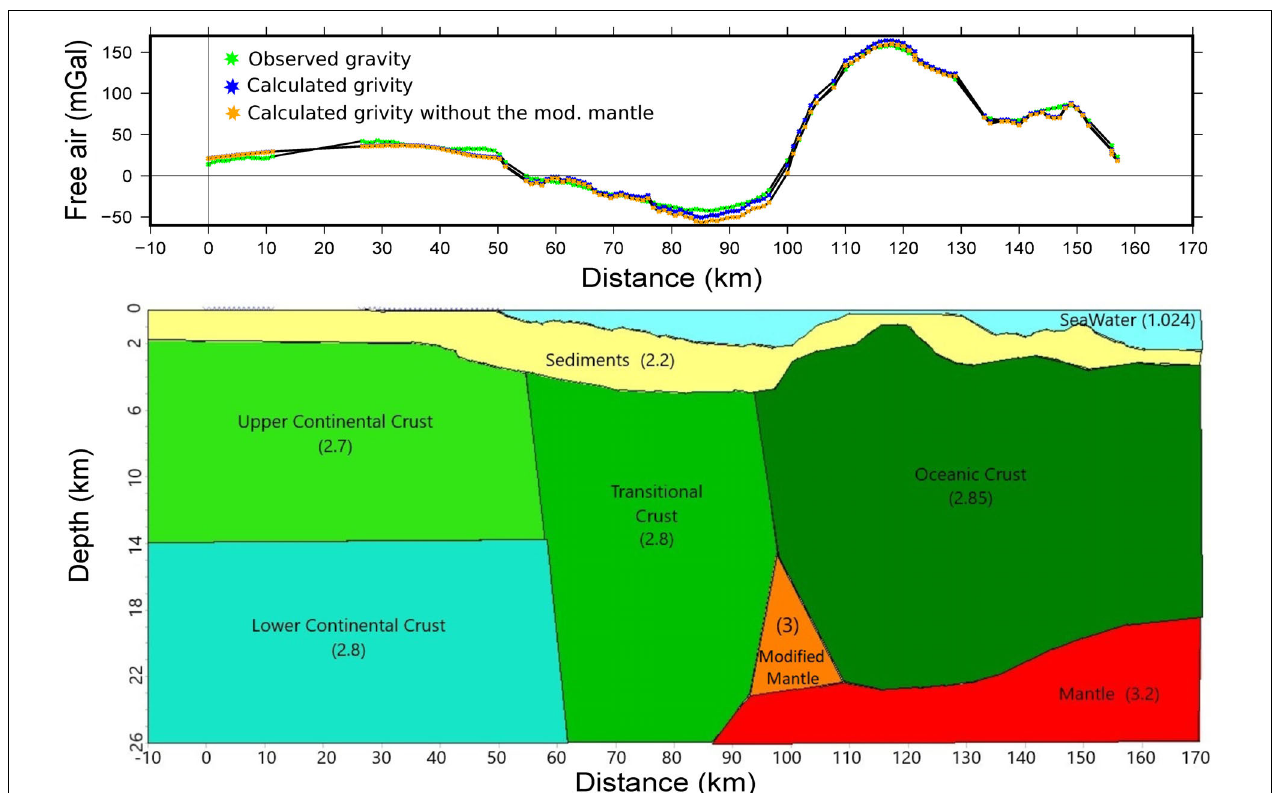
FIGURE 5 | Gravimetric model of the profile 8 (S-N) with 2.5 × vertical exaggeration (location is shown in Figure 3 ). Densities in g/cm 3